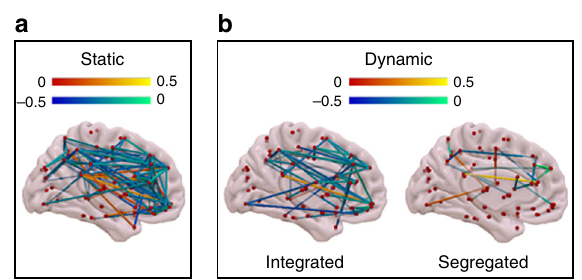
Fig. 2 Common differences in functional connectivity ( r values) when considering both awake volunteers > anaesthetized (repeated-measures t -test, FDR-corrected), and awake volunteers > DOC patients (two-samples t -test, FDR-corrected). a Differences from static FC (computed over the entire scanning length). b Differences from dynamic FC, observed only in the integrated state (left) or only in the segregated state (right). Hot colours indicate conscious > unconscious, and cold indicate unconscious > conscious (increased correlation, or decreased anticorrelation). Source data are provided as a Source Data fi